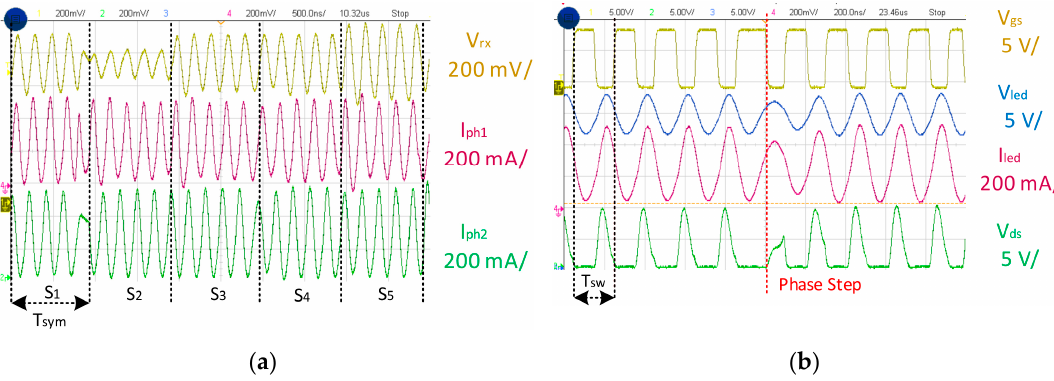
Figure 12. ( a ) communication waveforms of the light-Outphasing system; ( b ) main waveforms of the Class E RFPA during a phase